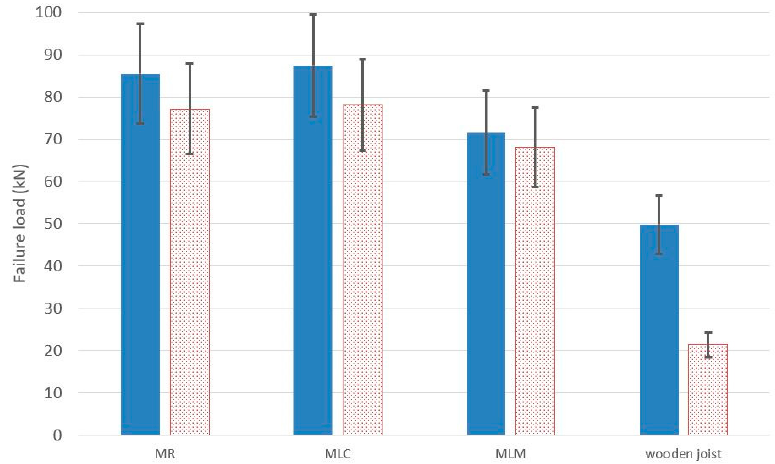
Figure 17. Moment on the x -axis (MPa).